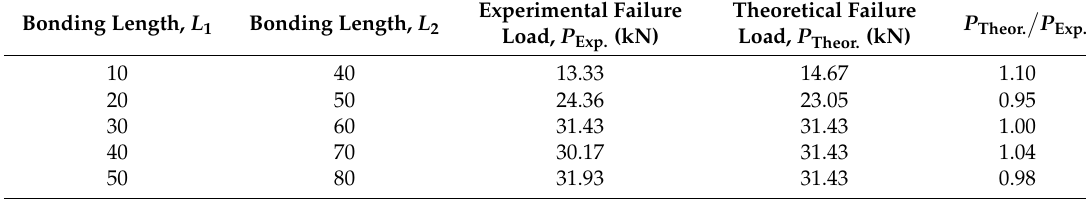
Table 3. Dimensions of the adhesive joints and details of experimental and theoretical failure loads for the tested DSJs.